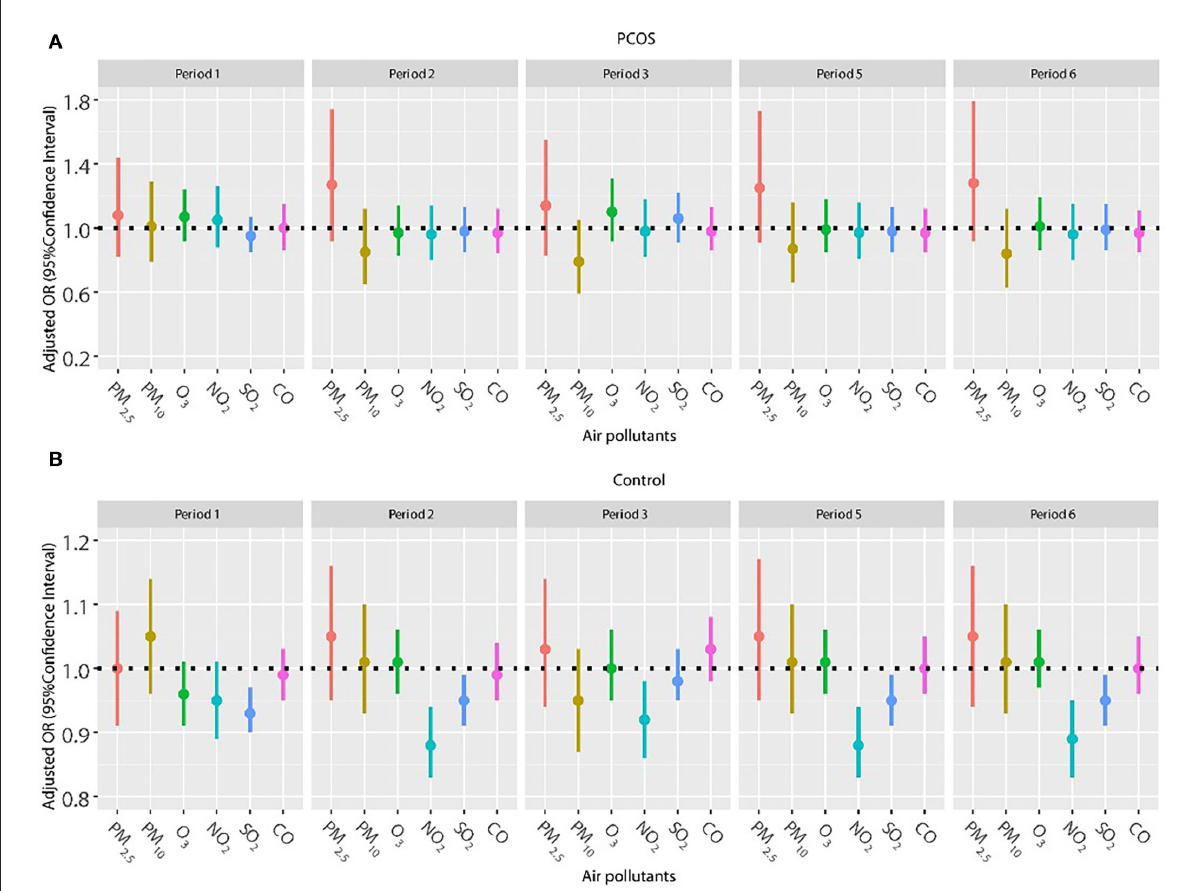
FIGURE2 (A,B) Association between ambient air pollution exposure and clinical pregnancy rate among women with and without PCOS with frozen embryo transfer. Results showed in bold indicated statistically significant associations. PM 2.5 , particulate matter ≤ 2.5 µ m, µ g/m 3 ; PM 10 , particulate matter ≤ 10 µ m, µ g/m 3 ; NO 2 , nitrogen dioxide, µ g/m 3 ; SO 2 , sulfur dioxide, µ g/m 3 ; CO, carbon monoxide, mg/m 3 ; O 3 , ozone, µ g/m 3 . Model adjusted for patients’ age ( < 30, 30–34, 35–39, and ≥ 40 years), BMI, education level, infertility type (primary or secondary infertility), infertility duration, infertility cause (female factor, male factor, both, and unexplained factor), number of embryos transferred (one or two), fertilization method (IVF, ICSI, or IVF + ICSI), endometrial thickness, and season of embryo transfer (spring, summer, autumn, or winter). Periods 1, 2, 3, 5, and 6 indicate the exposure windows shown in Figure